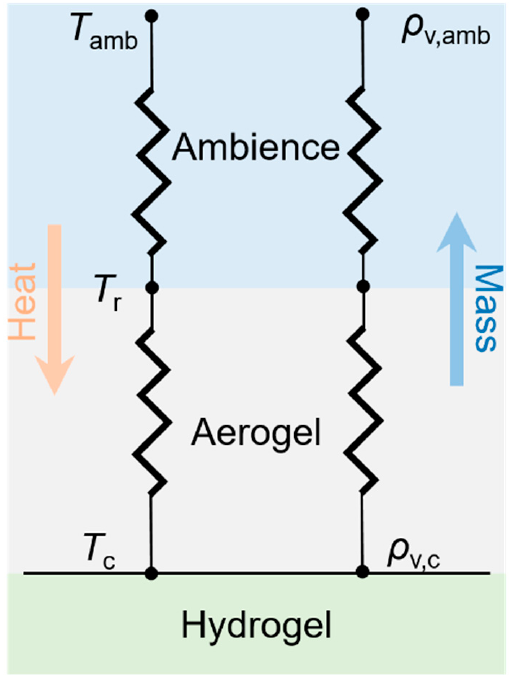
Figure 3. Schematic of heat and mass transfer processes for the bilayer structure.